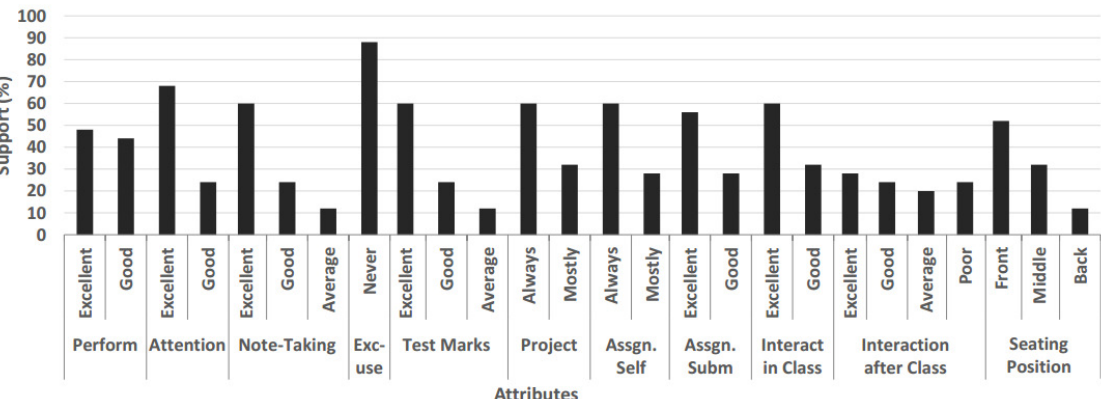
FIG 4: PATTERNS OF DATA SET 1